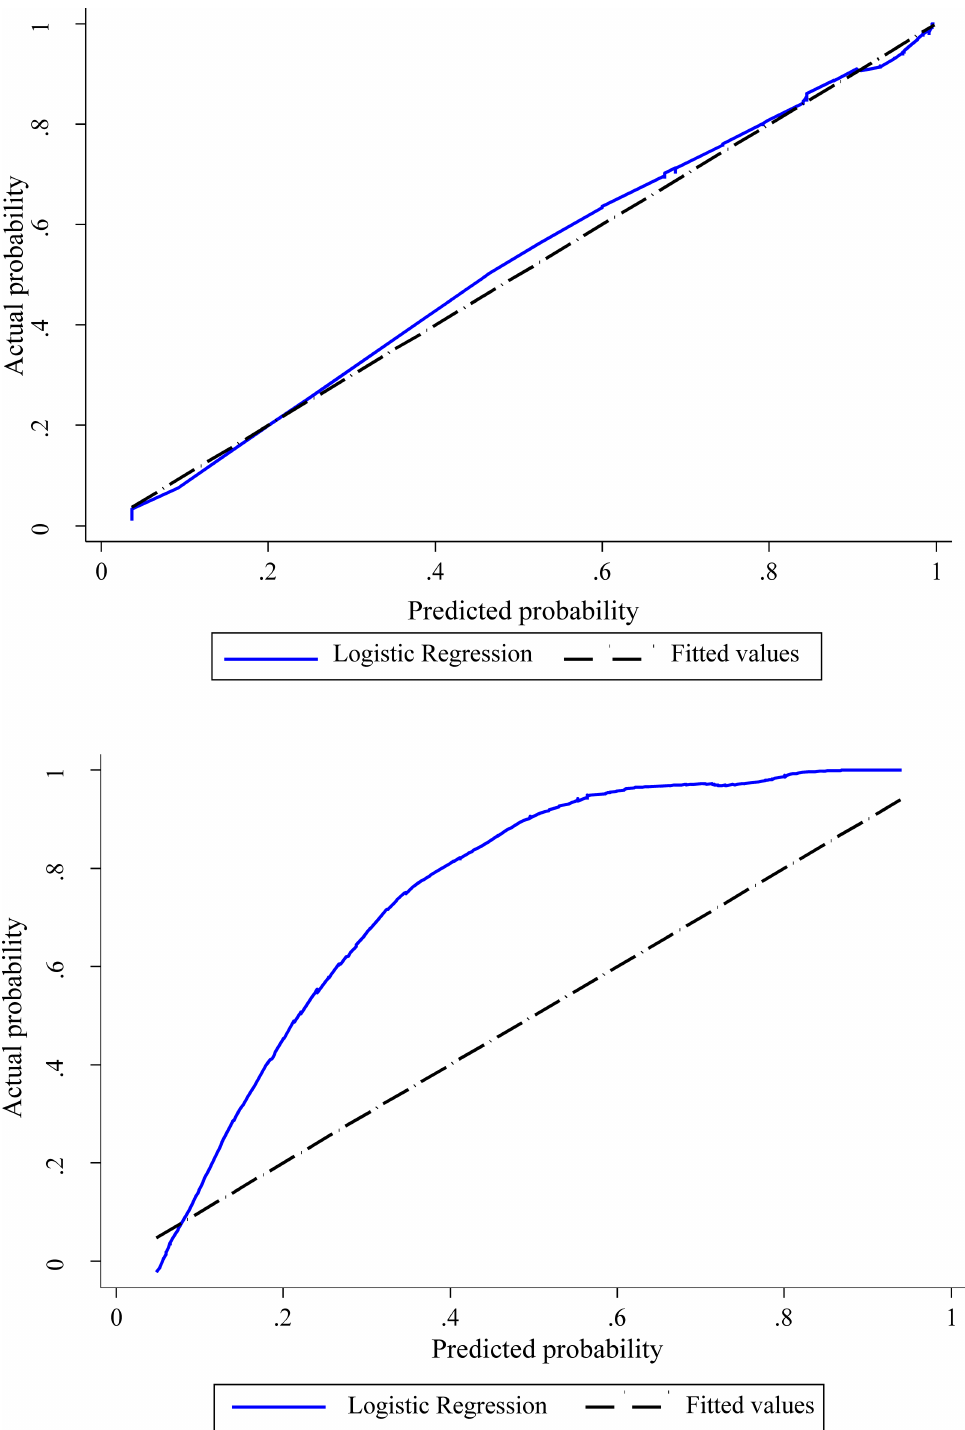
Fig 1. Calibration plot for model (i) and model (ii). Model (i) calibration shown in upper graph, model (ii) calibration shown in lower graph. The solid line is a smoothed curve that represents an estimate of the relation between the predicted and the observed probability of sciatica diagnosis. Ideally this line fits the dotted line that represents perfect calibration.